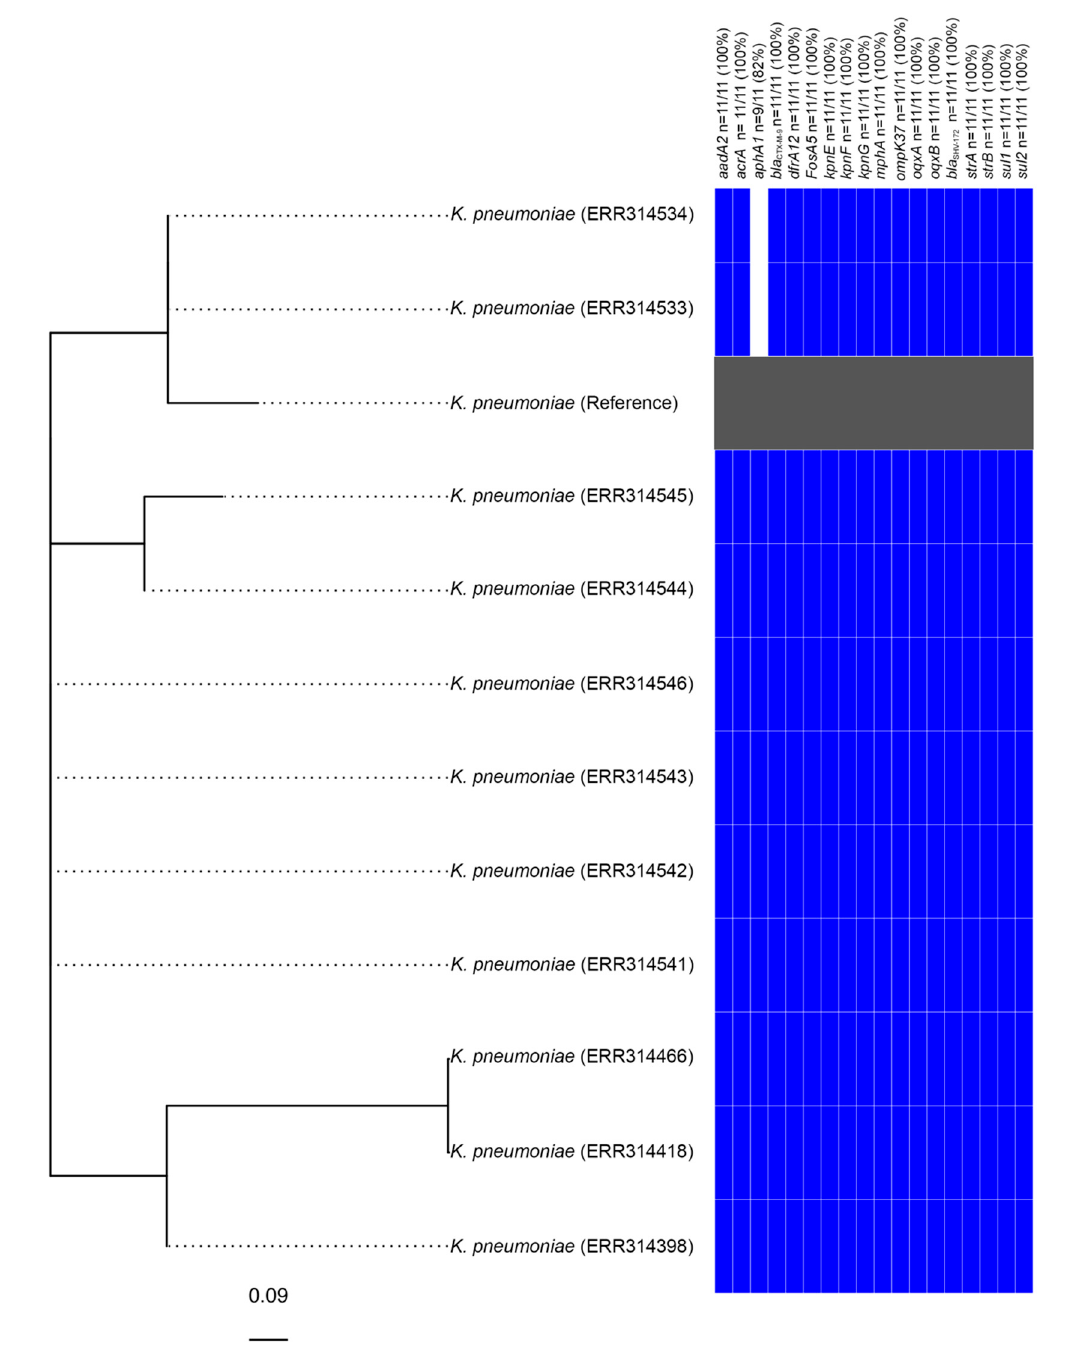
Figure 2. Phylogenetic analysis of Klebsiella strains found to carry KGI. The tree is unrooted and the reference strain utilised corresponds to an assembly of Klebsiella pneumoniae strain 2485STDY5477984 (SRA Accession No. ERR314534).